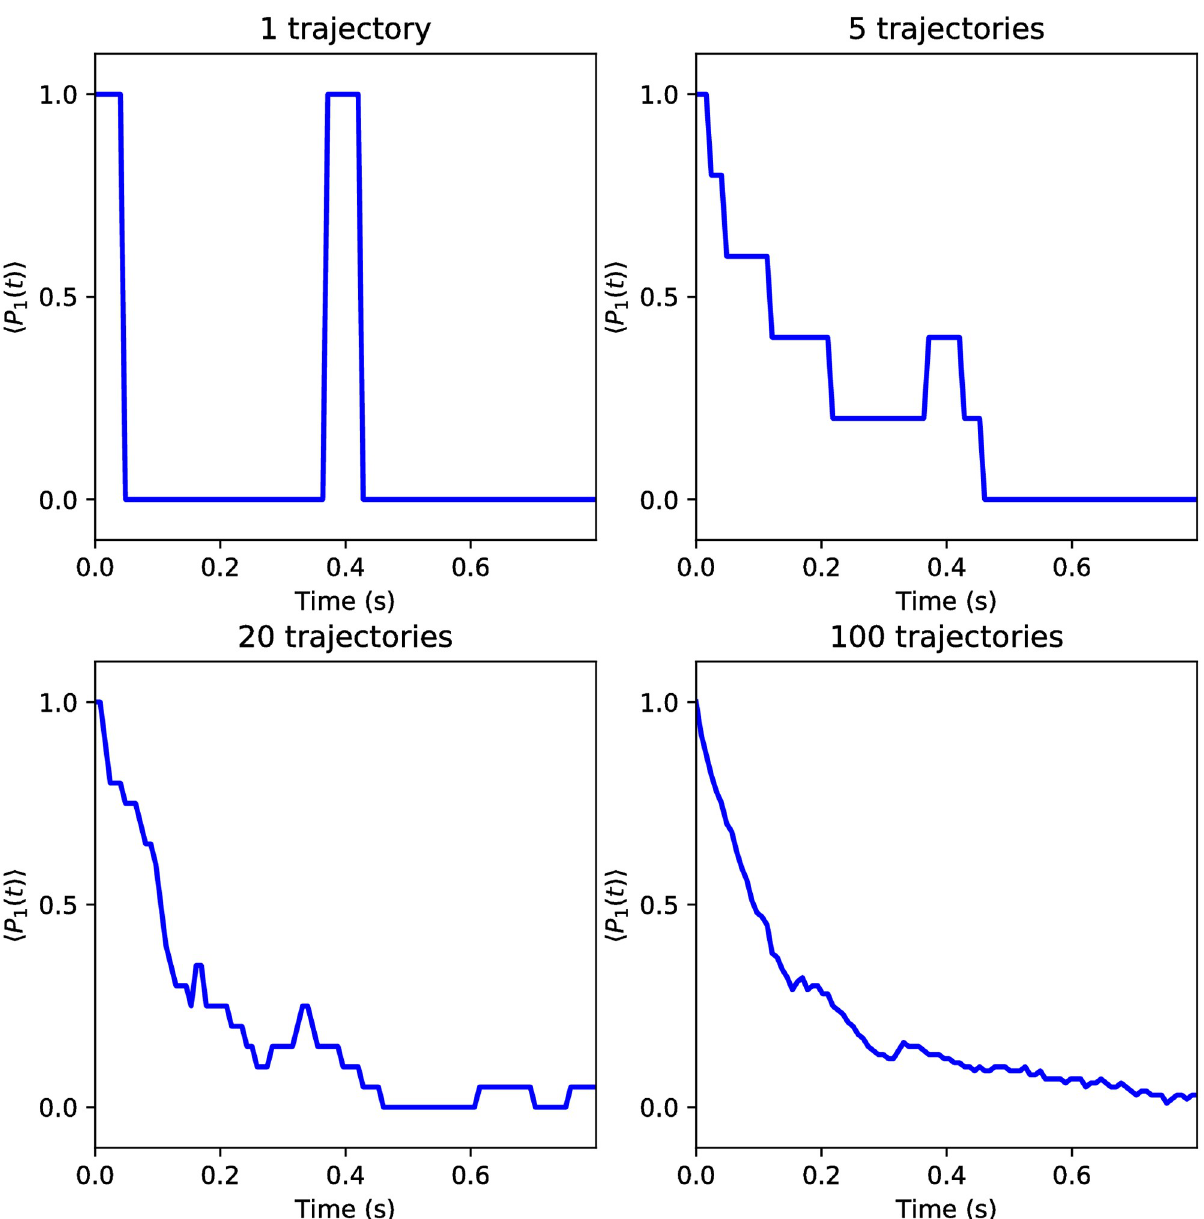
Fig 9. The probability of the decay for the one-photon state obtained with the different numbers of trajectories. Increasing the number of trajectories improves the accuracy of calculation.